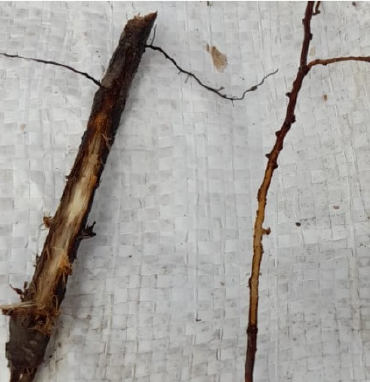
Figure 4. Root of pecan tree infected with P.